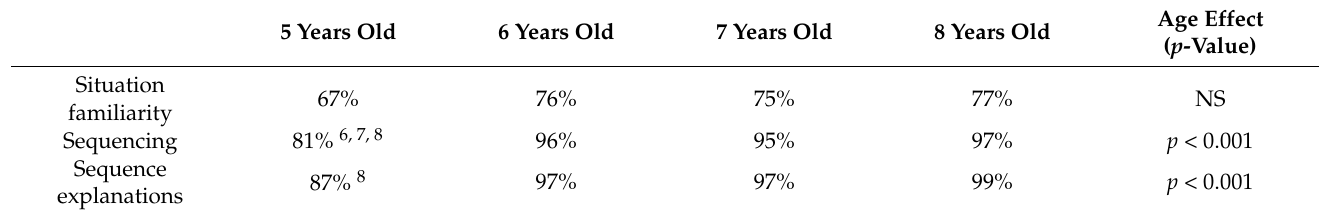
Table 3. Situation familiarity, sequencing and ability to explain the sequence for each age categories.